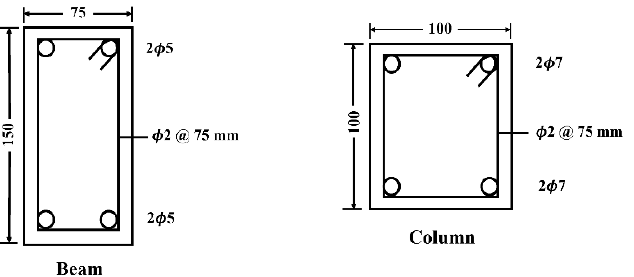
Figure 5. Comparison of analytical models in this study with experimental models [8]: ( a ) analytical and experimental results of the bare frame; ( b ) failure mechanisms of the bare frame based on the analytical model; ( c ) failure mechanisms of the bare frame based on the experimental model; ( d ) analytical and experimental results of the infilled frame; ( e ) failure mechanisms of the infilled frame based on the analytical model; ( f ) failure mechanisms of the infilled frame based on the experimental model.